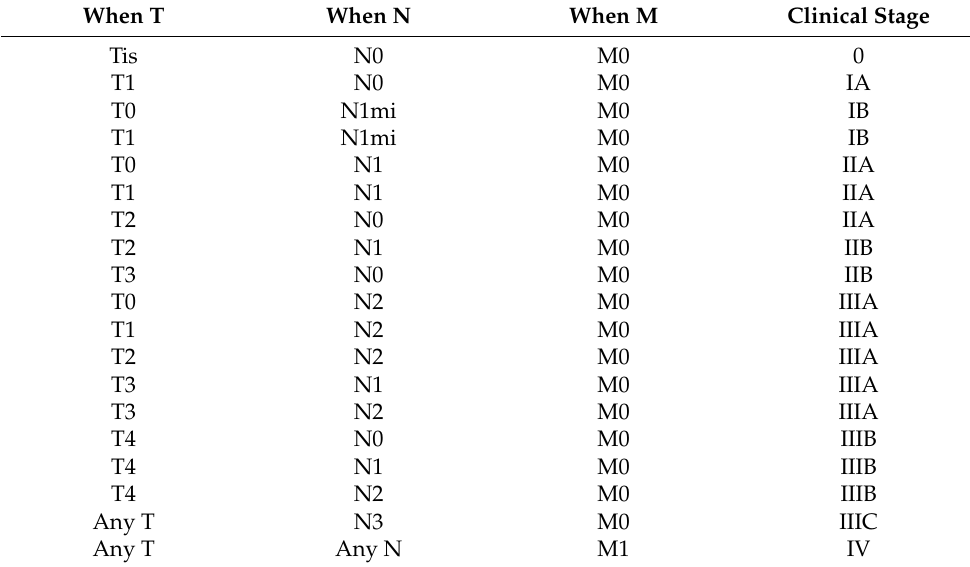
Table 2. TNM system of breast